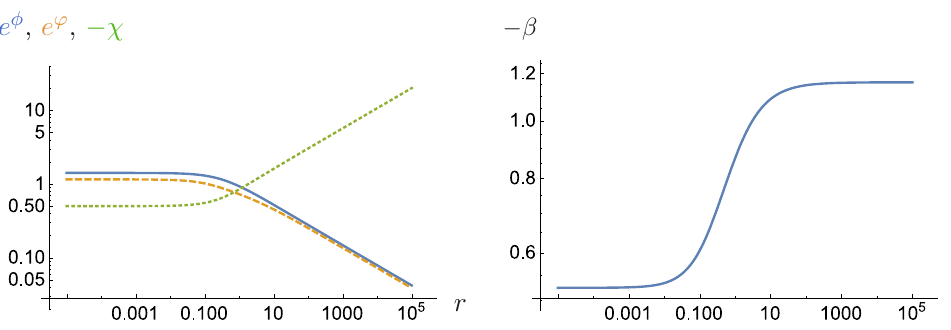
Figure 4 . Plots of the scalars e φ (blue, straight line), e ϕ (brown, dashed line) and dotted line), as well as of the phase β , as a function of the radial coordinate for a solution with − ( c 1 , c 2 ) = (1 . 138 , 1 . 68) . −